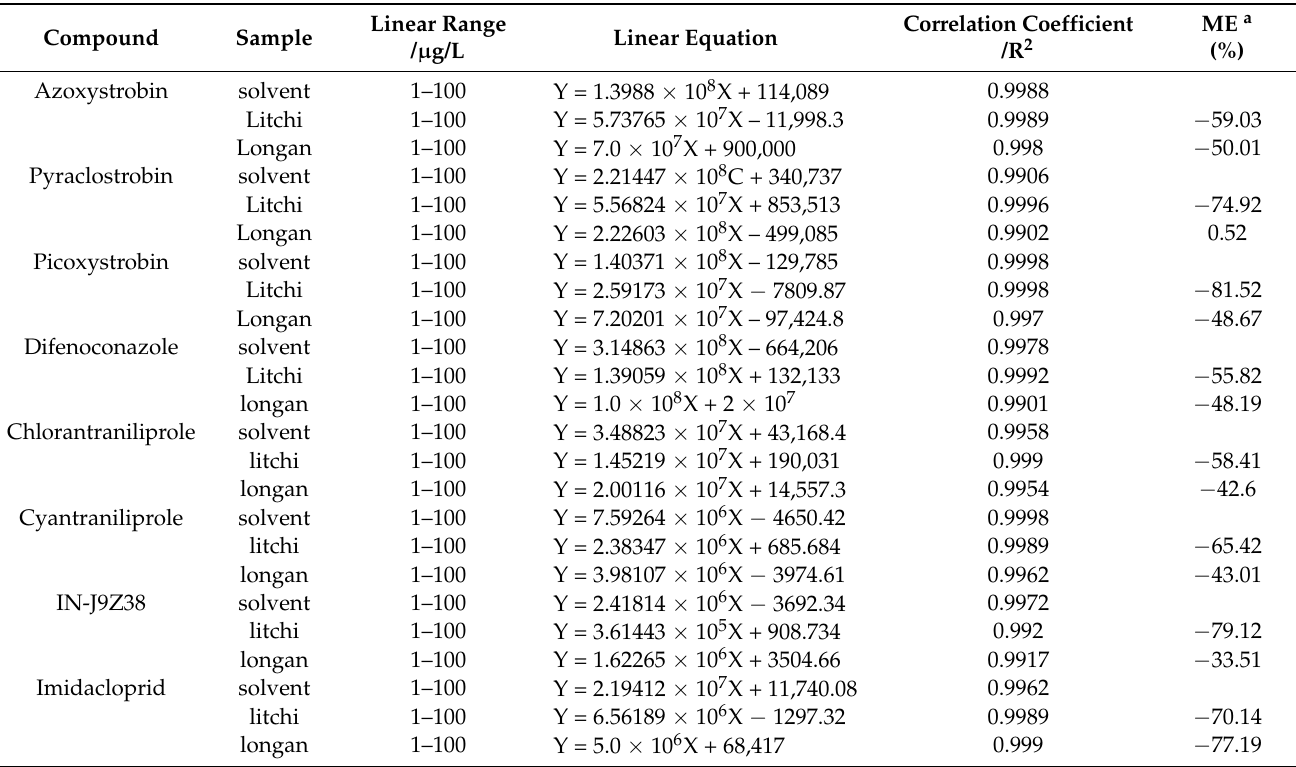
Table 3. Linear equations and matrix effect of eight targeted compounds in litchi and longan samples ( n =